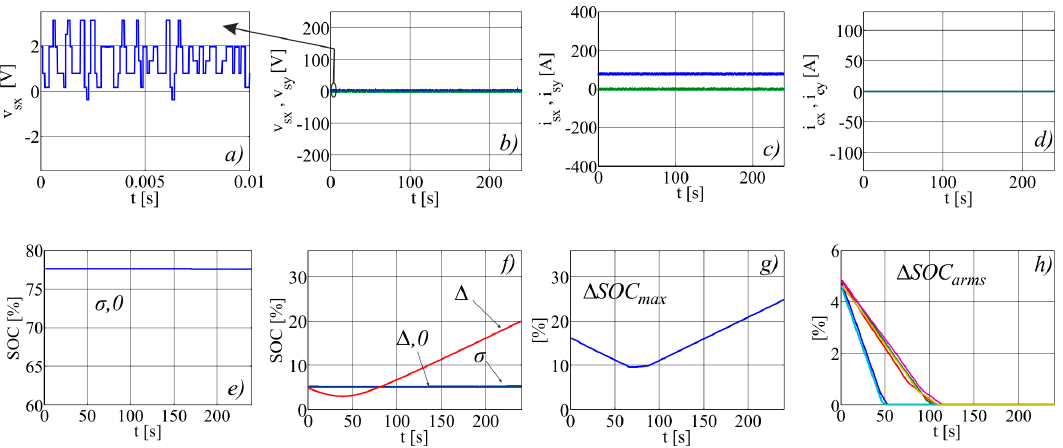
Figure 6. Numerical results for zero speed deactivating the balancing control: ( a ) zoom of x motor voltage component; ( b ) x,y motor voltage components; ( c ) x,y motor current components; ( d ) x,y circulating current components; ( e ) half of the zero-sequence component of the arms sum SOCs; ( f ) unbalance SOC terms; ( g ) difference between the maximum and the minimum SOC of all cells; and, ( h ) difference between the maximum and the minimum SOC of the six arms.